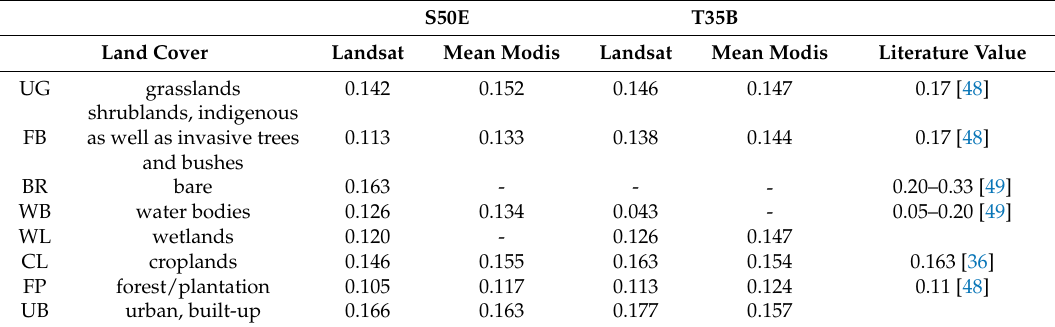
Table 4. Study area albedo values compared to literature.